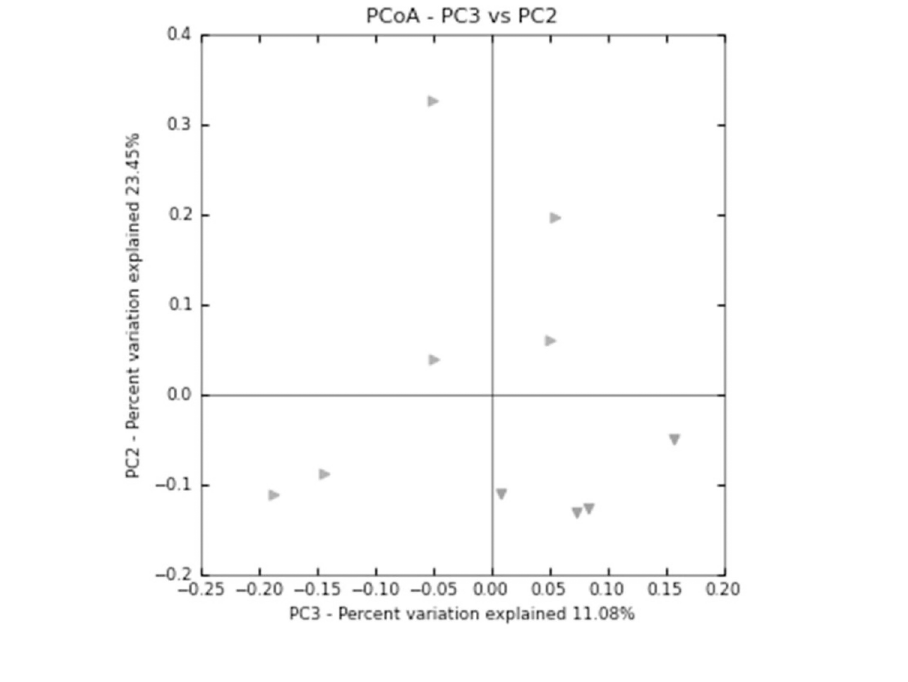
Fig 3. Principal coordinate analysis (PCoA) plot of samples from ground and flight mice. Flight mice data points clustered relatively tightly within the bottom right quadrant, whereas ground controls are distributed throughout the remainder of the plot. The PCoA analysis illustrates the differences in bacterial populations in the feces of flight mice compared to ground controls.